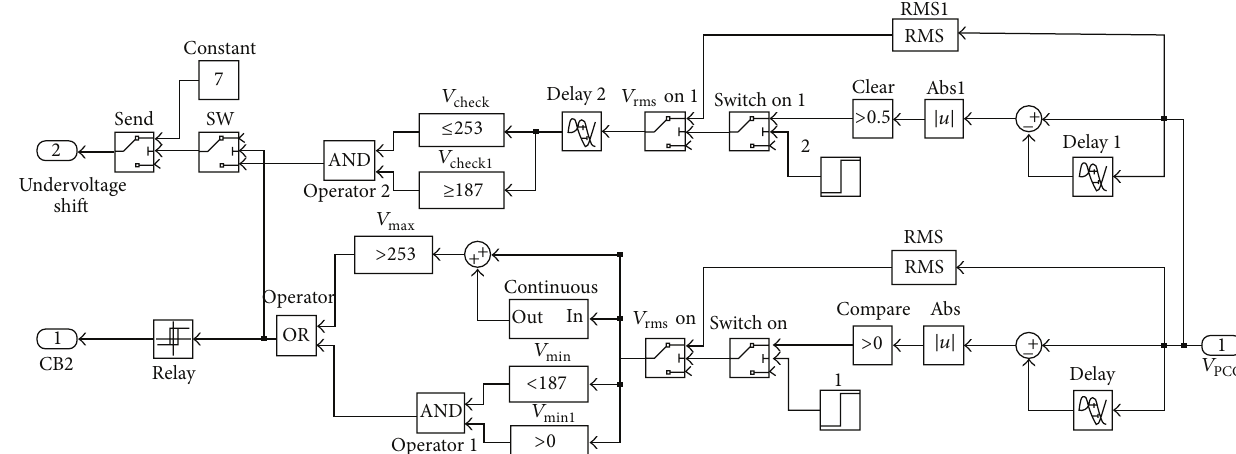
Figure 15: Over/undervoltage and undervoltage shift